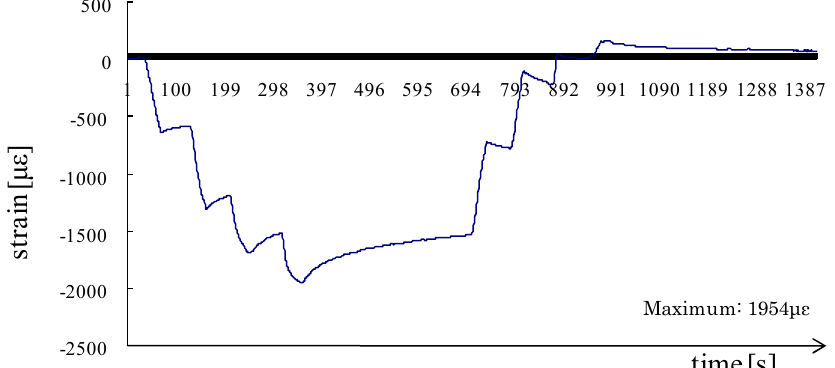
Fig. 4 Measurement of the strain under the load.